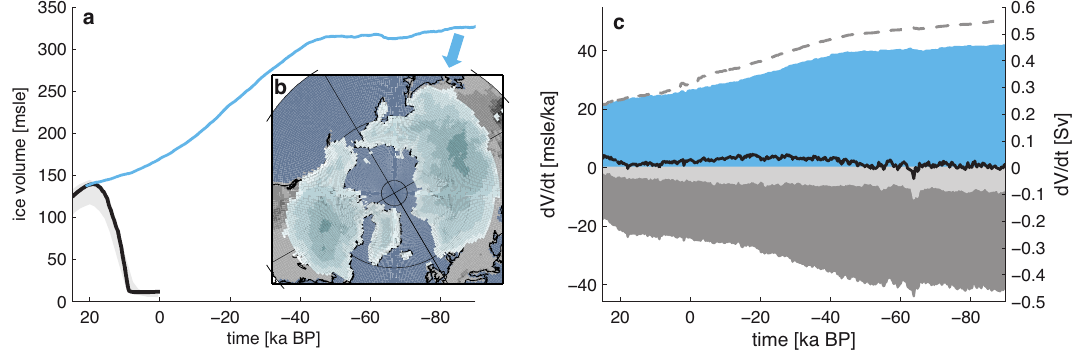
Figure 6. (a) Northern Hemisphere ice sheet volume in meters sea level equivalent (ms.l.e.) for CTR (black), and for fixed LGM (21kaBP) greenhouse gas concentrations and orbital parameters (blue line); gray shading indicates sea level reconstructions (Waelbroeck et al., 2002). (b) Bedrock height and ice sheet thickness at − 90kaBP (see Fig. 3 for color scales). (c) Accumulation (blue area), ablation (light gray shading), basal melting and calving (dark gray shading), net mass balance (thick black line), and ice sheet area for comparison (dashed line) scaled as in Fig. 2b.